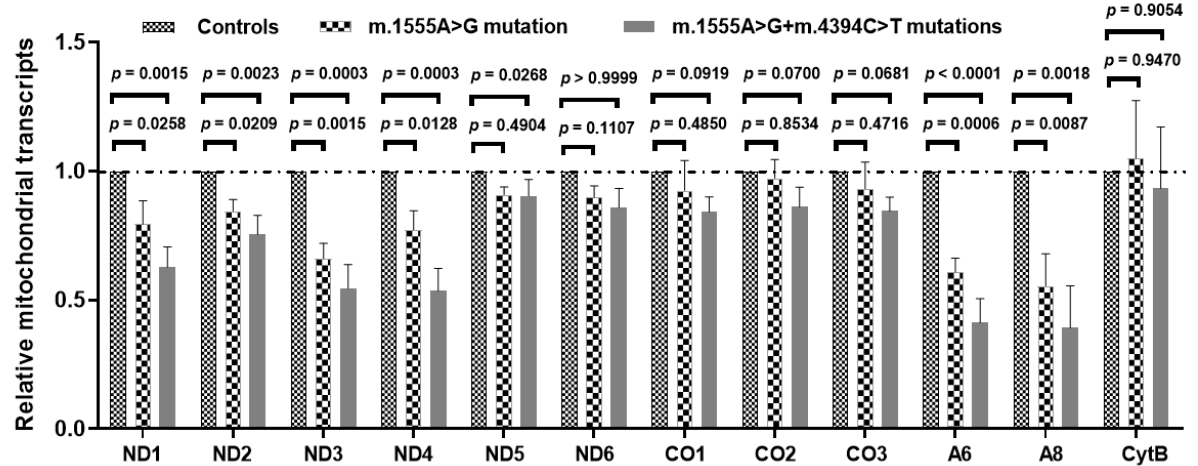
Figure 8. Mt-RNA transcription analysis in three patients with both the m.1555A>G and m.4394C>T mutations, three patients with only the m.1555A>G mutation and three controls.